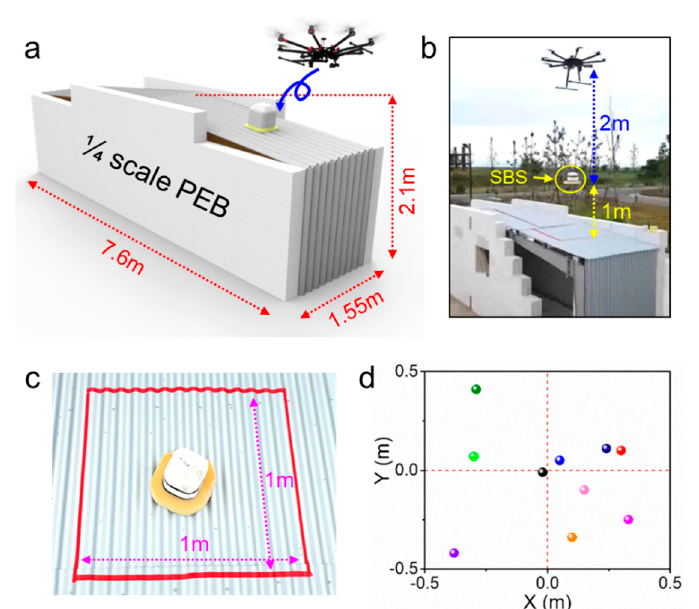
Figure 7. ( a ) Schematic and ( b ) photographic image of the SBS deploying process using a drone during the testbed experiments; ( c ) deployed SBS, dropped from the drone at a height of 1 m; ( d ) positional distribution from 10 trials of the drop-deployment test.